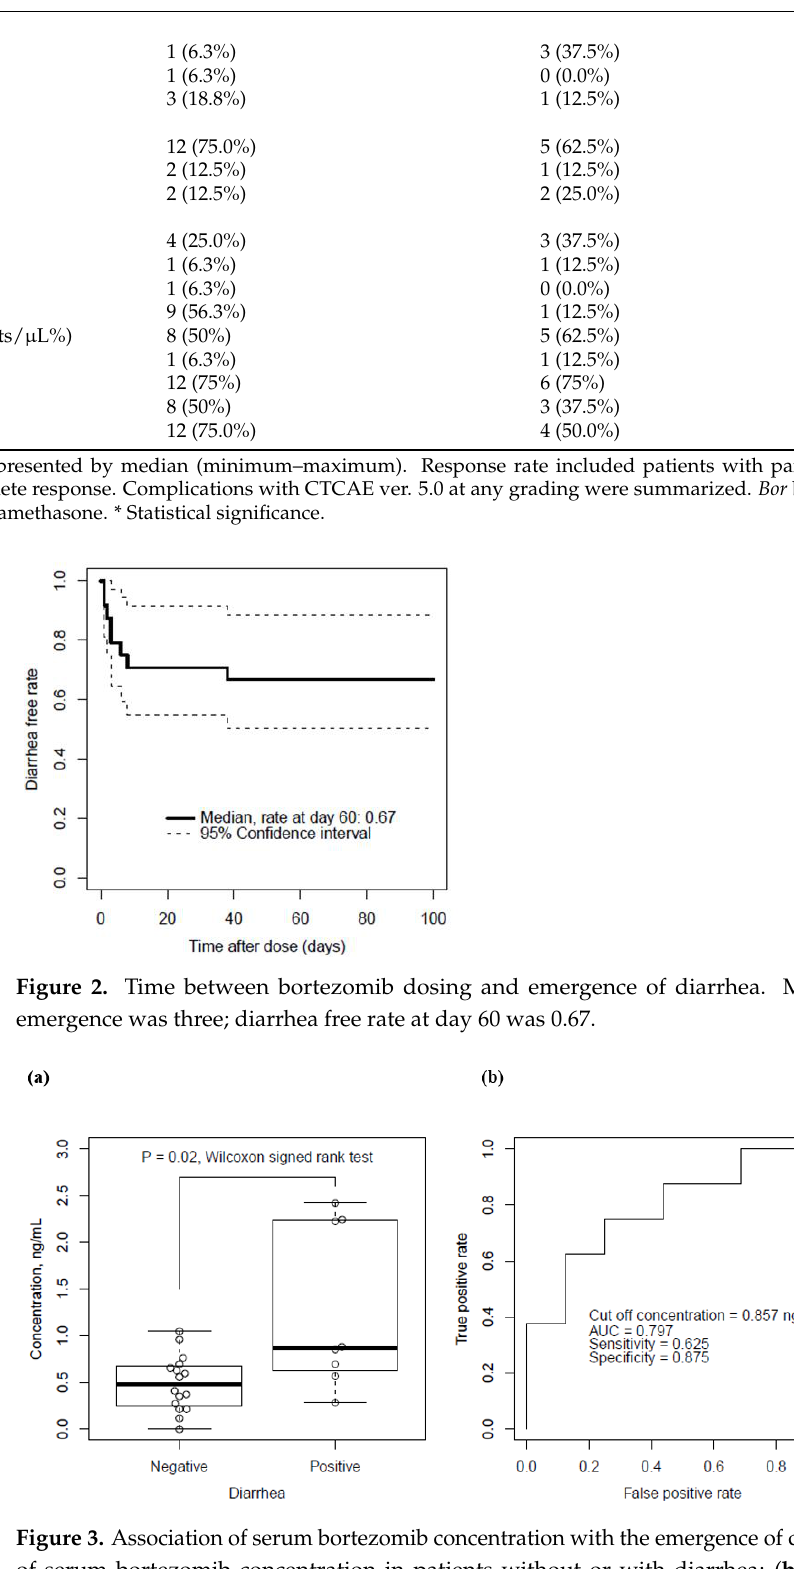
Figure 4. Survival curves in patients with bortezomib therapy. ( a ) Survival curves in the patients with (bold line) or without (dashed line) diarrhea; ( b ) survival curves in patients with higher con- centration (>median, bold line) or lower concentration (≤median, dashed line). The median concen- tration was 0.61 ng/mL.